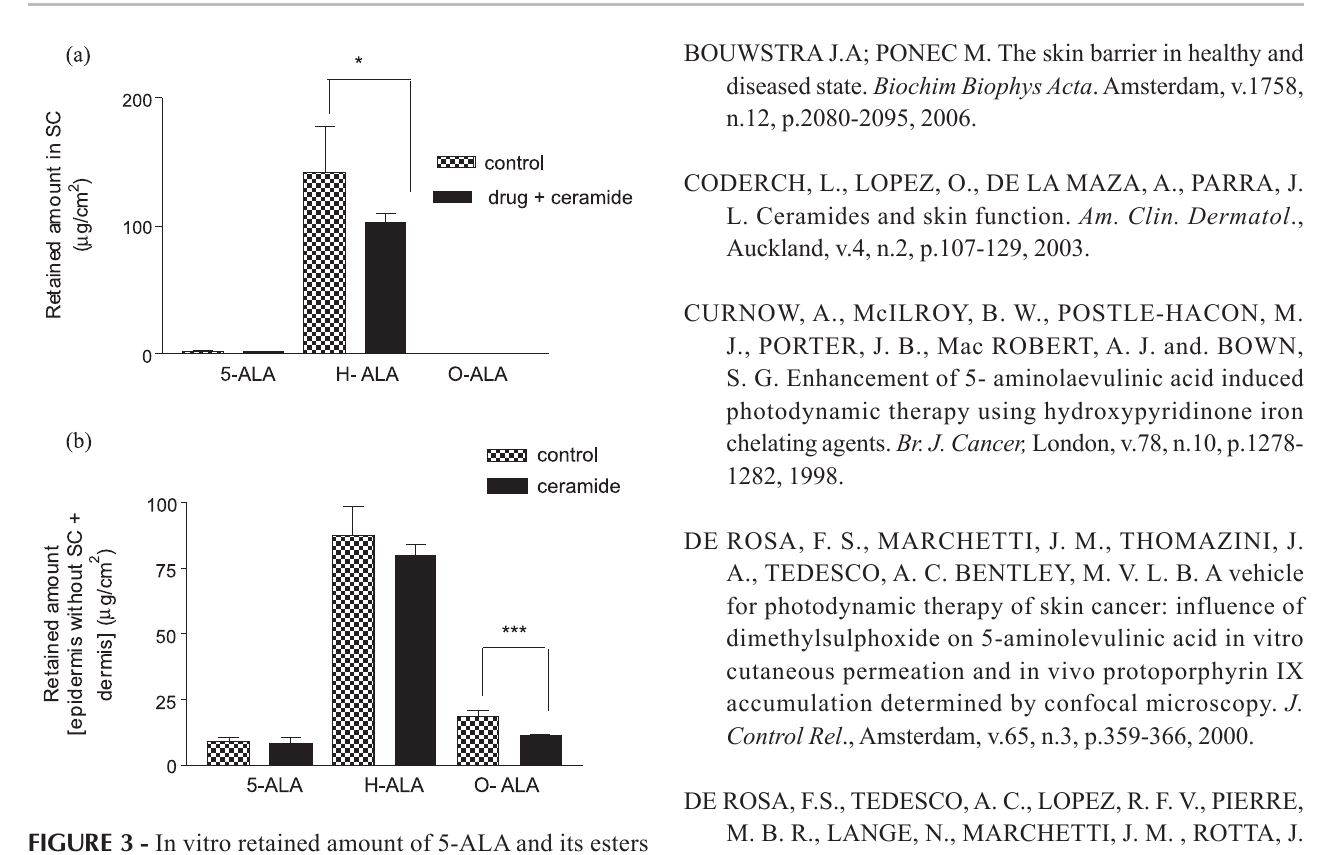
FIGURE 3 - In vitro retained amount of 5-ALA and its esters into: ( a ) SC and ( b ) [epidermis without SC + dermis] in porcine ear skin, after 16 h of permeation study from PG solution and mixture with ceramide (2.0% w/w) in PG. Percentage of drugs in the formulation: 1.0% (w/w). Values are expressed as S. M. E (n=4) for each group. Values signifcantly different between formulation and control for H-ALA retained in SC (P < 0.01*), and between formulation and control for O-ALA retained in [epidermis without SC + dermis] (P < 0.05).